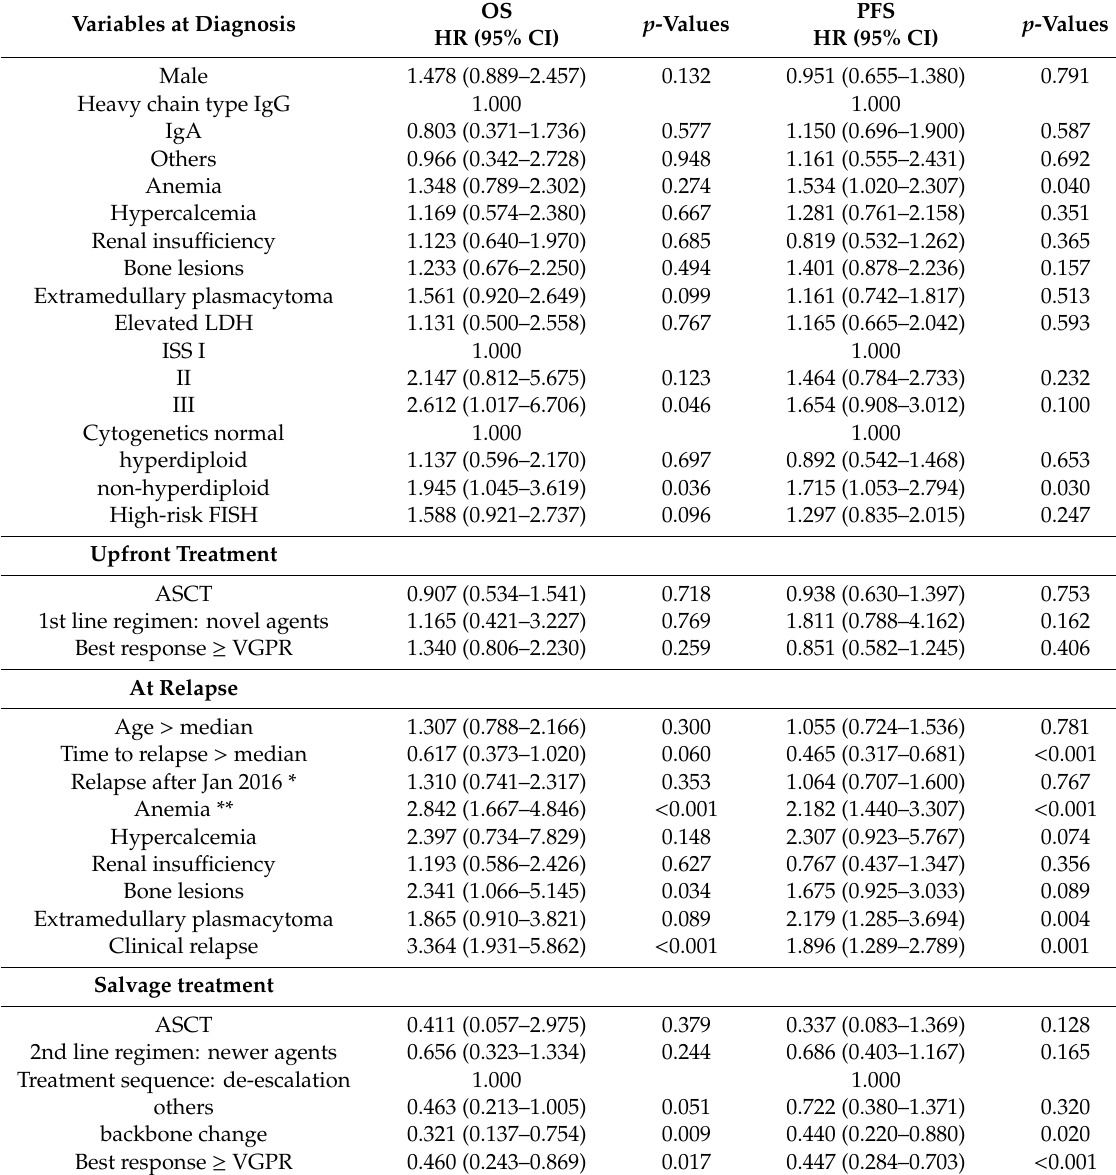
Table 2. Univariate Cox analysis of the testing